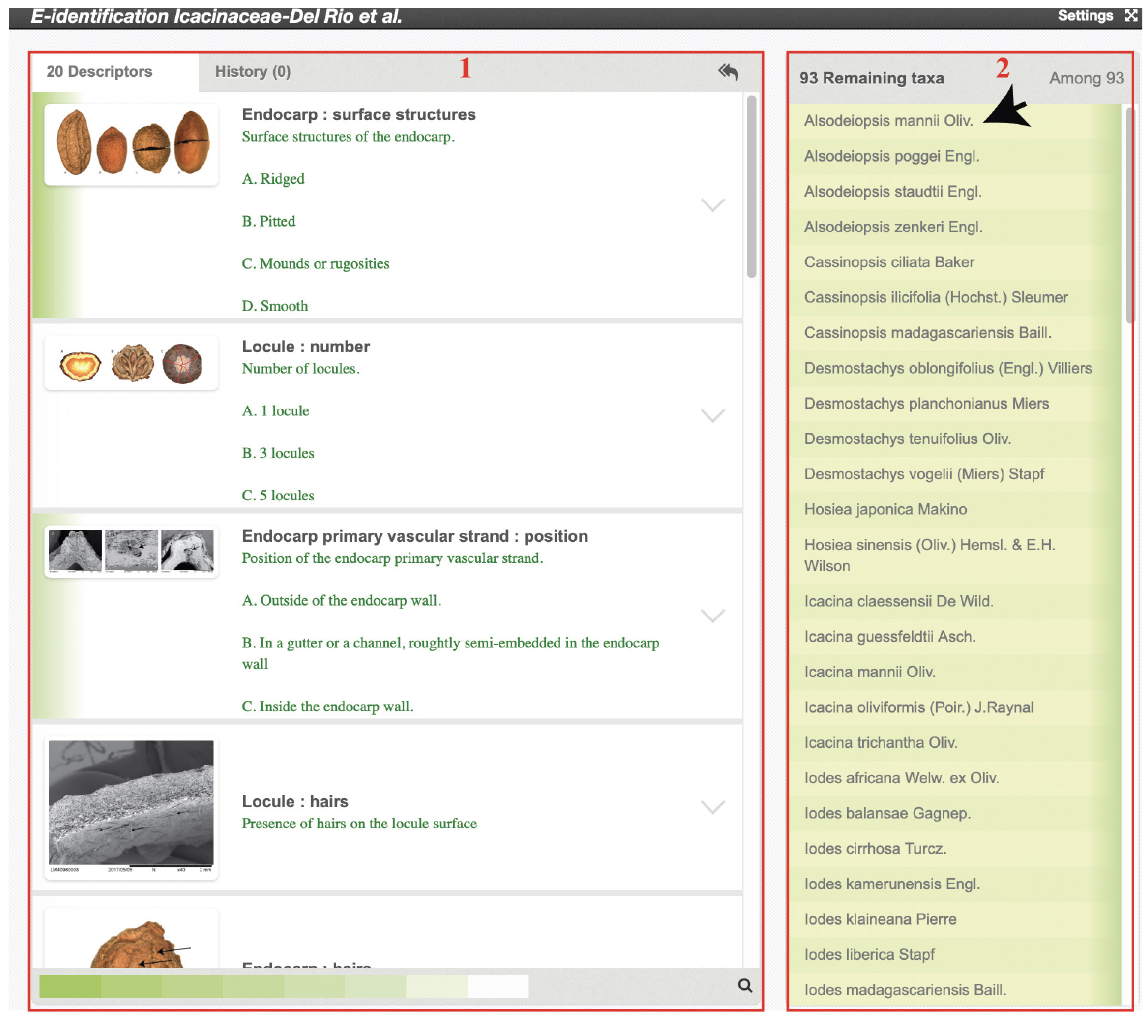
Fig. 4. Interactive identification view in Xper 3 database. 1 . Descriptors. 2 . Remaining